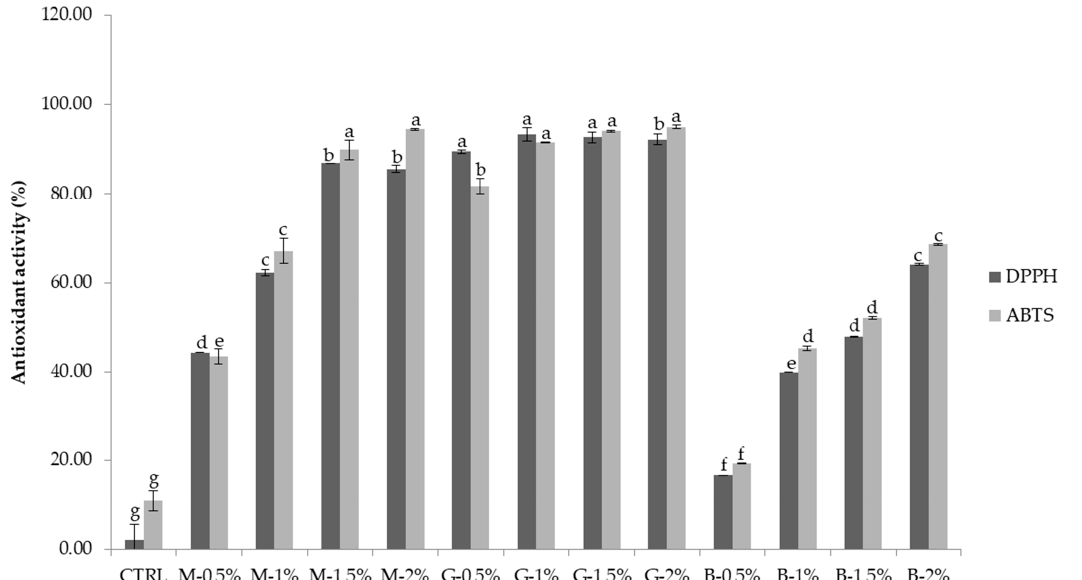
94.4% (0.5–2%: MTN addition), 95.0% (0.5–2%: GTN addition), and 68.48% (0.5–2%: BTN addition), respectively. The TPC in DTN samples ranged from 97.32 mg/g to 540.97 mg/g (Figure 3). GTN recoded the highest TPC compared to MTP and BTP, with the highest values at G 1.5% (540.97 mg/g) and G 2% (523.42%), as shown in Figure 3.